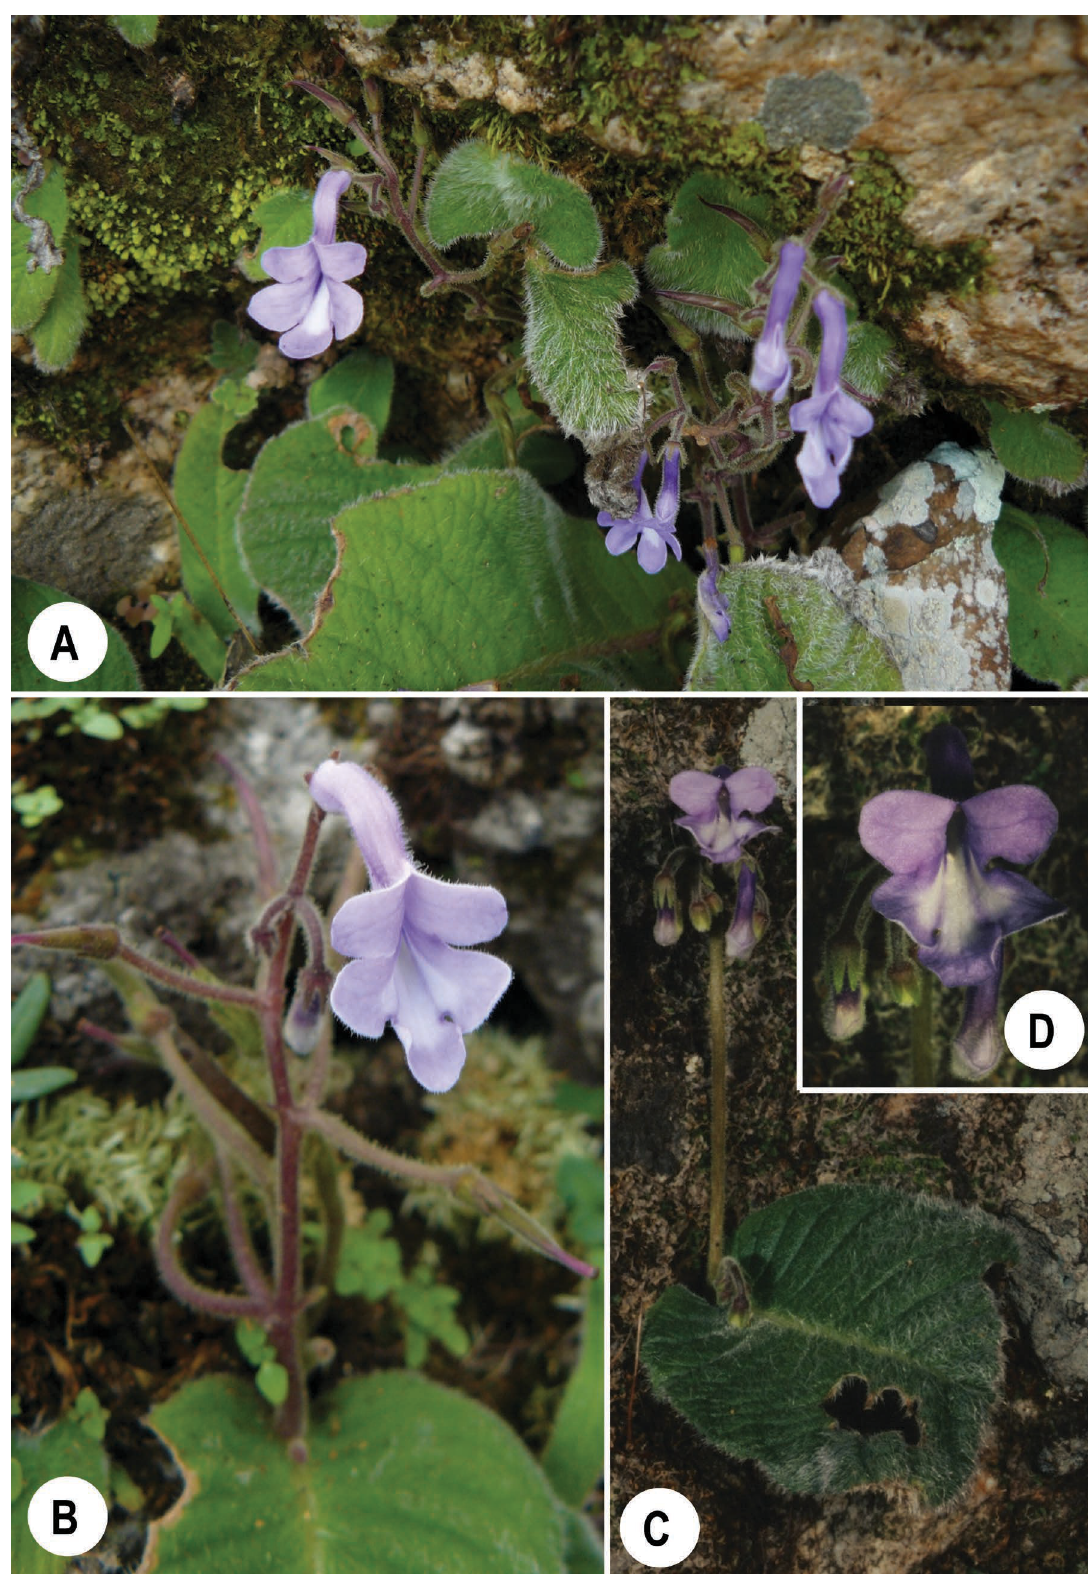
Figure 2 – Streptocarpus malachiticola . A, C . Habit. B . Inflorescence. D . Flower. Photographs taken by Julie Lebrun, Biodiversity and Landscape Unit, Gembloux Agro-Bio Tech, University of Liège at Tshilongo, Kabwe (A–B: © Julie Lebrun, all rights reserved) and Michel Schaijes at Tenke (C–D: © Michel Schaijes, all rights